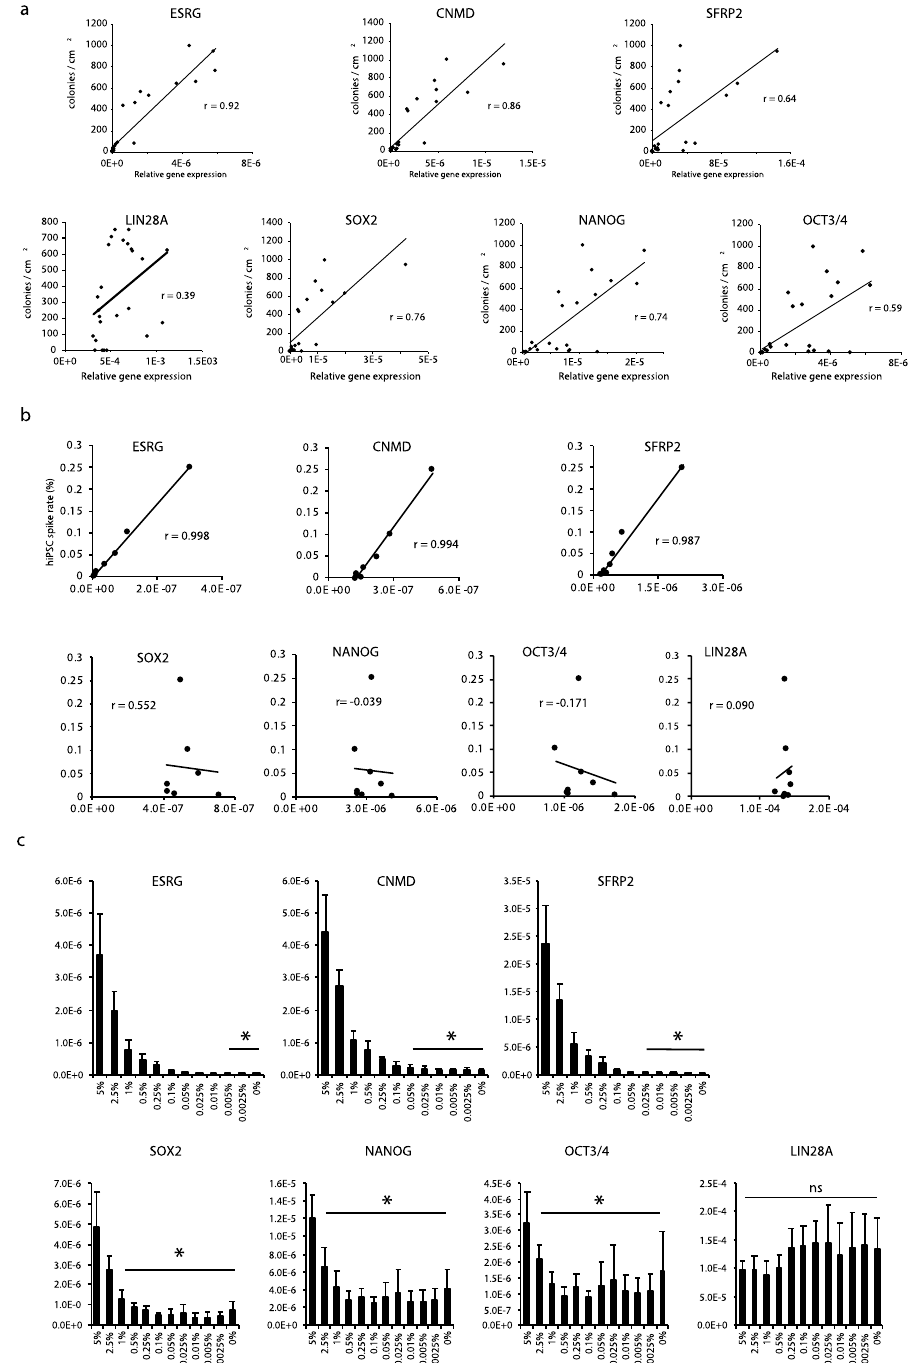
Figure 3. Correlation of marker gene expression with practical residual undifferentiated cells. ( a ) Correlation between gene expression and residual undifferentiated iPSC in HE. X–axes represent relative gene expression by qPCR and Y–axes represent actual residual colony number per cm 2 when HE cells were re-seeded at a density of 8 × 10 4 cells/cm 2 . ( b ) Correlation between spiked-in iPSC and gene expression of novel marker genes. X–axes represent relative gene expression by qPCR and Y–axes represent spiked-in undifferentiated iPSC percentage. ( c ) Detection limits of residual undifferentiated iPSC for novel markers and well-known iPSC marker genes. * p values < 0.05. The all relative expression levels were normalized by the amount of 18S rRNA in each